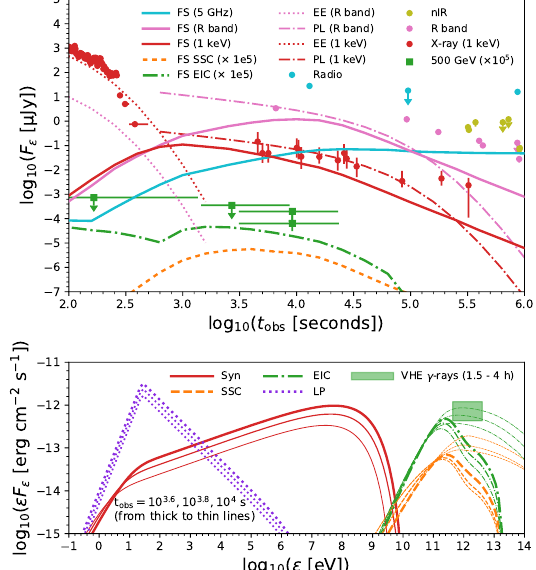
Figure 13. GRB160821B: modeling of multi-wavelength light curves (top panel) and simultaneous SED (bottom panel) in radio, optical, X-ray and VHE band presented by [157]. ©AAS. Reproduced with permission. Two scenarios are considered: SSC (dashed orange lines) and EIC (dash-dotted green lines). In the top panel, the flux contribution in the different energy bands due to the forward shock (FS) both in the SSC and in the EIC scenario, the extended X-ray emission (EE) and the X-ray plateau emission (PL) are shown. In the bottom panel for the VHE band, both the intrinsic (thin lines) and the absorbed (thick lines) VHE curves are shown for the SSC and EIC scenarios for three different observed times. For the lower energies, the broken power-law of the late prompt emission (dashed violet line) and the expected synchrotron SEDs (solid red line) are displayed. The MAGIC observations (green symbols and green shaded area) are absorbed by